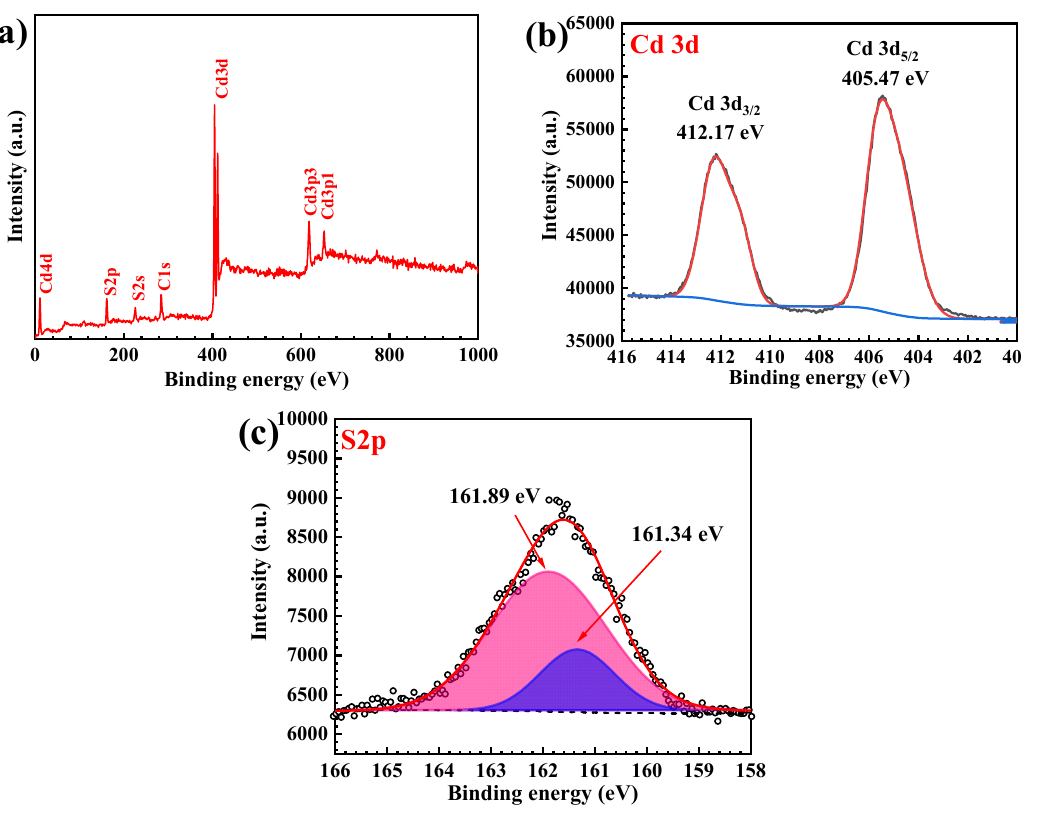
Figure 4. Typical XPS survey scan of CdS ( a ), the high-resolution XPS spectrum of Cd3d ( b ), and S2p ( c ).